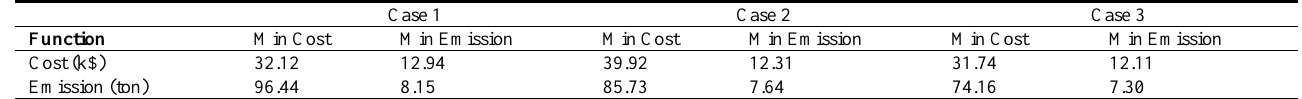
TABLE IV R ANGE OF O BJECTIVE F UNCTIONS IN E ACH C ASE (P AYOFF T ABLE )